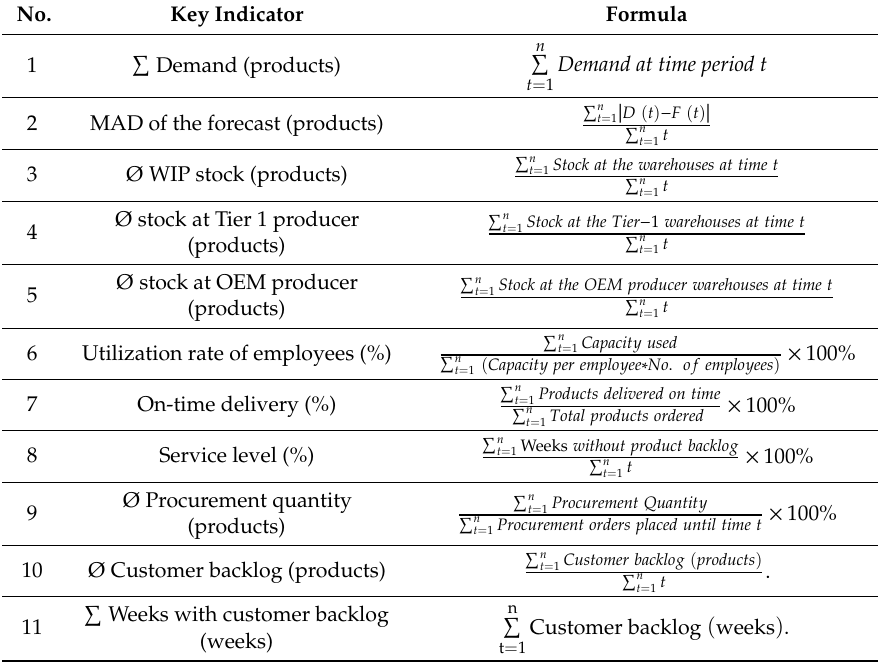
Table 7. KPIs for an inventory management model (own elaboration based on [42,43] and